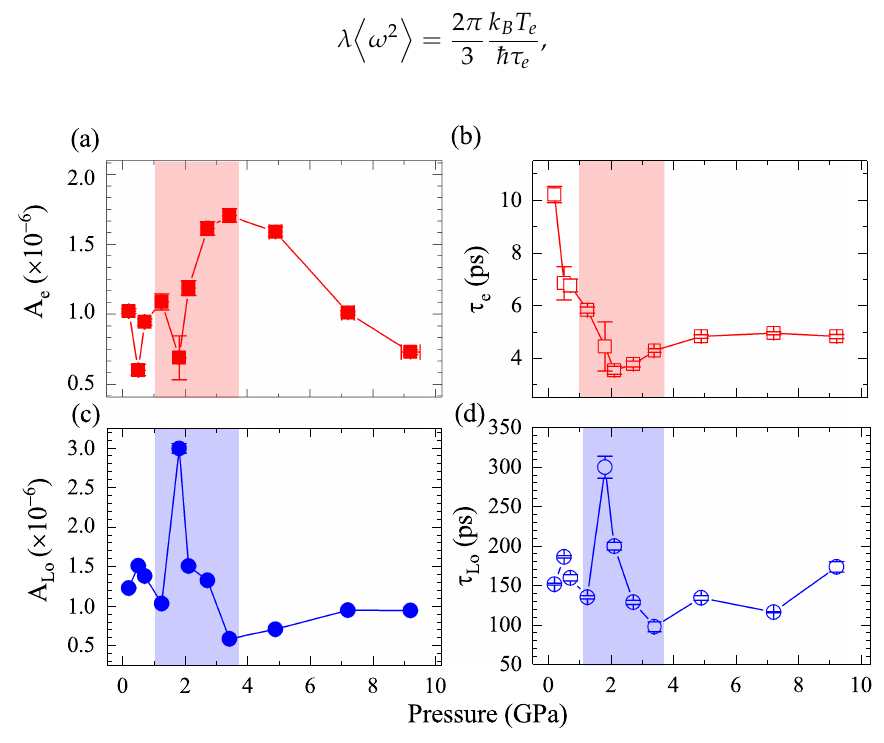
Figure 3. Pressure dependence of the amplitude ( a ) A e , ( c ) A LO and the relaxation time ( b ) τ e , ( d ) τ LO . The red symbols are the fitting parameters of electrons obtained by Equation (1), while the blue symbols denote those of the LO phonons. The solid and open symbols denote the amplitude and relaxation time of the fitting results,